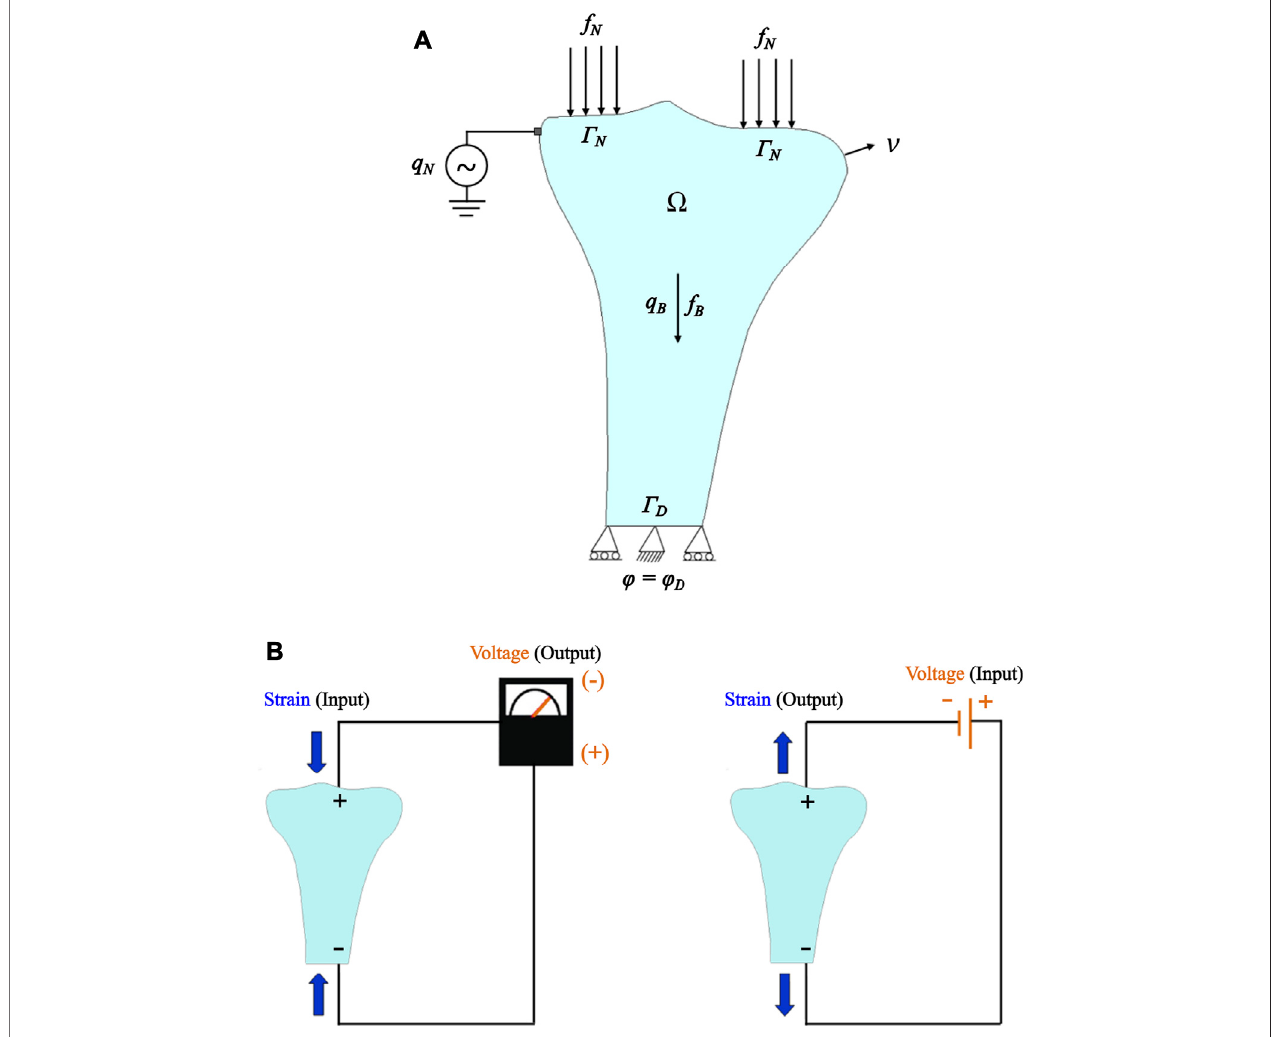
FIGURE 1 | (A) The tibia bone domain and schematic representation of boundary conditions implemented for piezoelectric bone remodeling simulations under electrical stimulation. (B) Exemplary representation of the direct and converse piezoelectric effect in tibia bone.